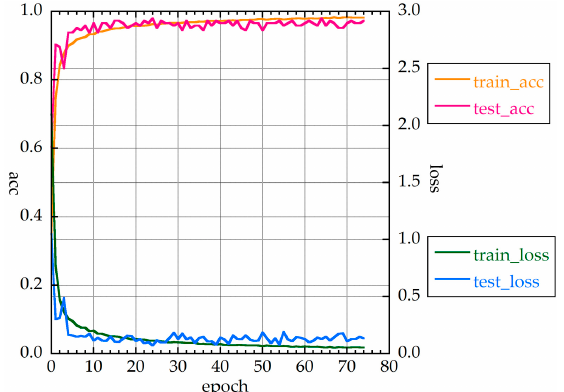
Figure 10. Accuracies and loss function values of MLP_S with HQ (MLP_S_HQ).